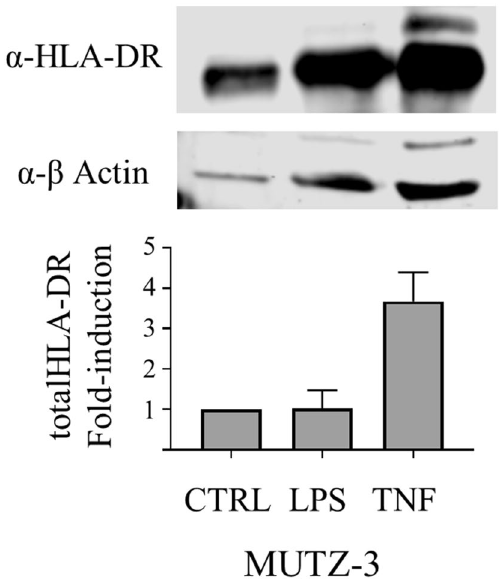
Figure 3. Detection of HLAII by Western Blot recapitulates increase in membrane associated-HLADR levels in MUTZ-3 cells induced to maturation. Detection of HLA-DR protein in whole lysates from MUTZ-3 cells by western blot (n = 3), each bar represents the mean and the SD. Total HLA-DR signal was normalized to the control (β-actin) and subsequently, fold induction upon LPS- and TNF-treatments was calculated based in unstimulated MUTZ-3 (CTRL).